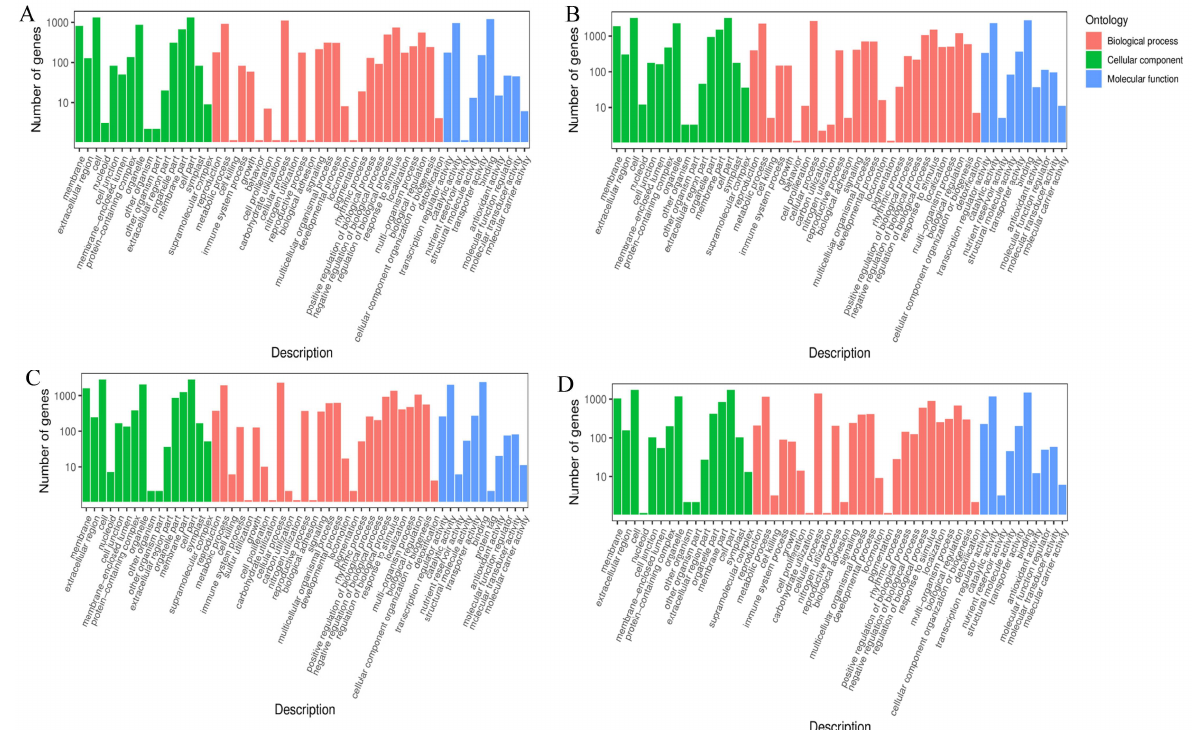
Figure 4. GO analysis of DEGs of A. pseudosieboldianum under freezing stress at different temperatures. The Y and X axes correspond to GO terminology and the number of DEGs. The ( A ) figure shows the comparison of −10 °C treatment and 4 °C treatment; the ( B ) diagram shows the comparison of −20 °C treatment and 4 °C treatment; the ( C ) diagram shows the comparison of −30 °C treat- ment and 4 °C treatment; and the ( D ) diagram shows the comparison of −40 °C treatment and 4 °C treatment.